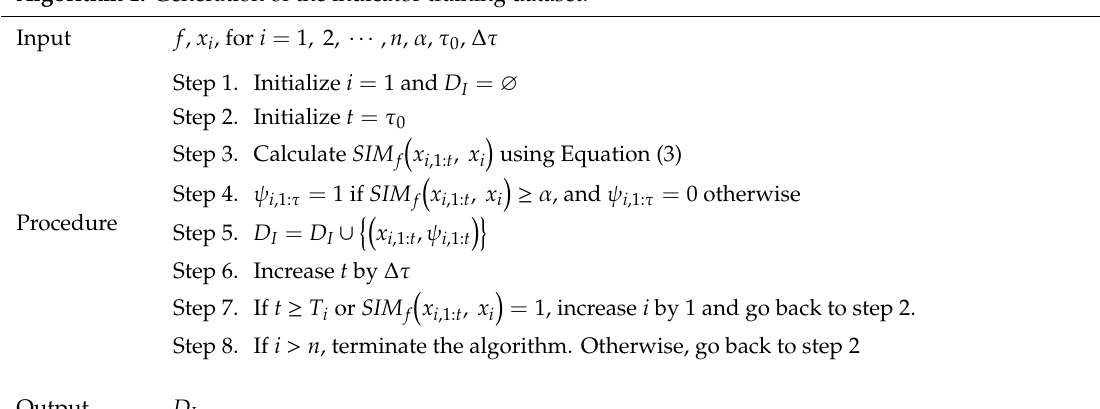
Algorithm 1. Generation of the indicator training